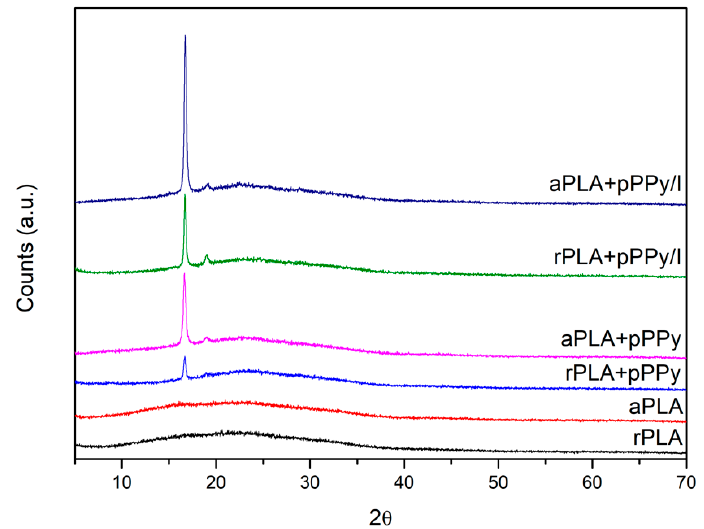
Figure 5. X ‐ Ray diffraction patterns of fabricated scaffolds. Figure 5. X-ray diffraction patterns of fabricated scaffolds.